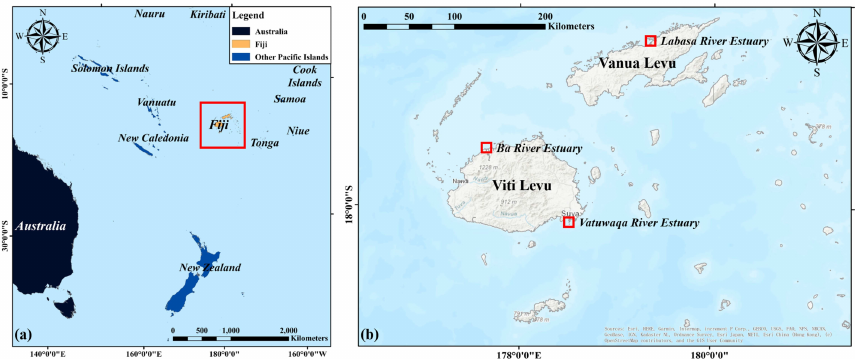
Figure 1. Location of study area ( a ) and two largest islands in Fiji: Viti Levu and Vanua Levu ( b ). The red box area in ( b ) shows the estuaries of the three largest rivers entering the sea in Fiji. Geographic map was obtained from Environmental Systems Research Institute: http://www.esri.com